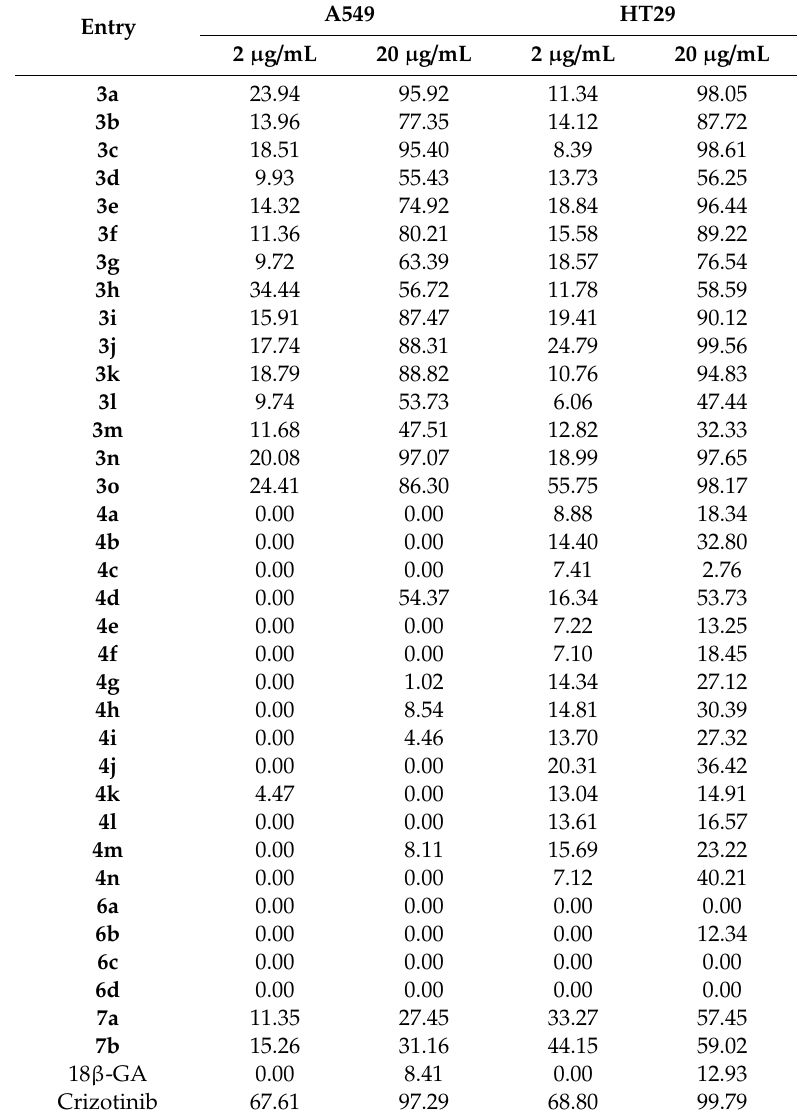
Table 2. Antiproliferative activity of the target compounds (growth inhibition,